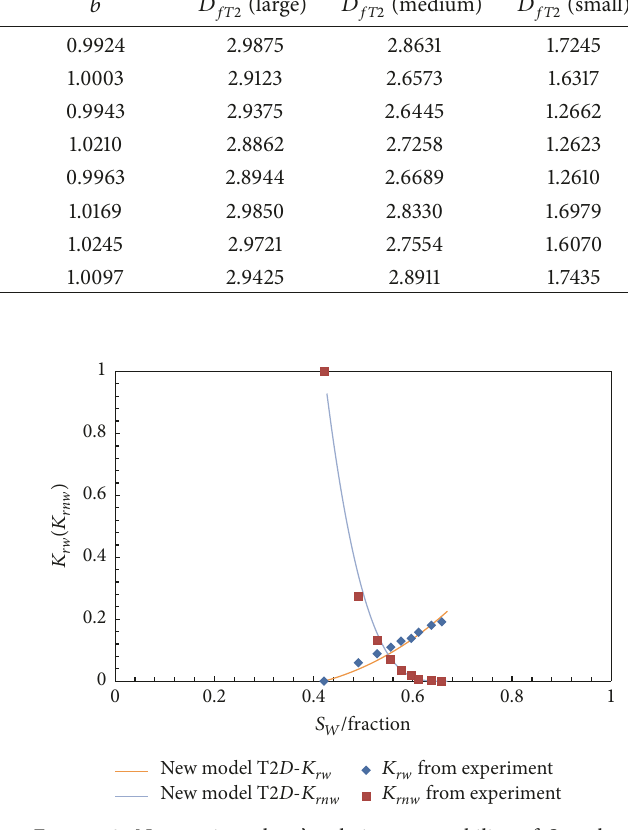
Figure 8: Nonwetting phase’s relative permeability of Sample 4 calculated by (24).